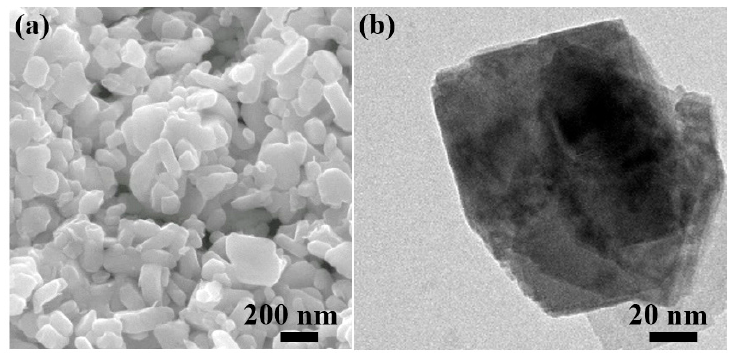
Figure 2. ( a ) SEM image and ( b ) TEM image of as-received WS 2 particles.